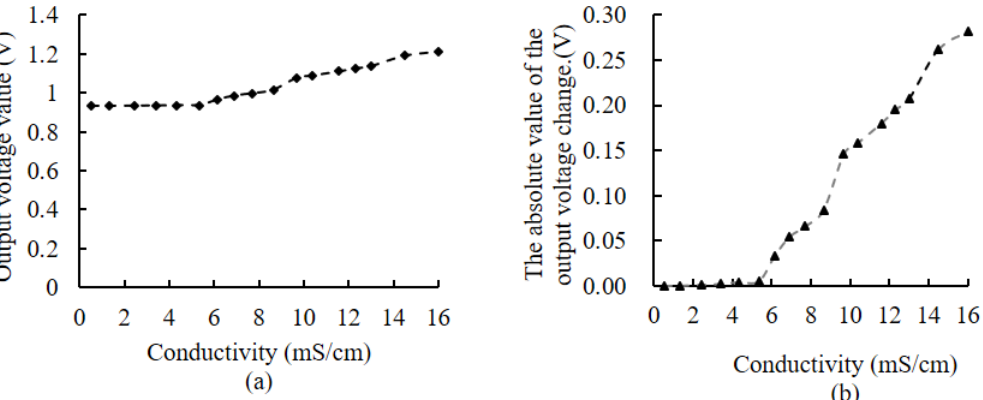
Figure 14. The response of the impedance measurement circuit to changes in the branch conductivity. ( a ) The variation of output voltage with conductivity. ( b ) The variation of the absolute value of the output voltage change ( ∆ ϕ n ) with conductivity.